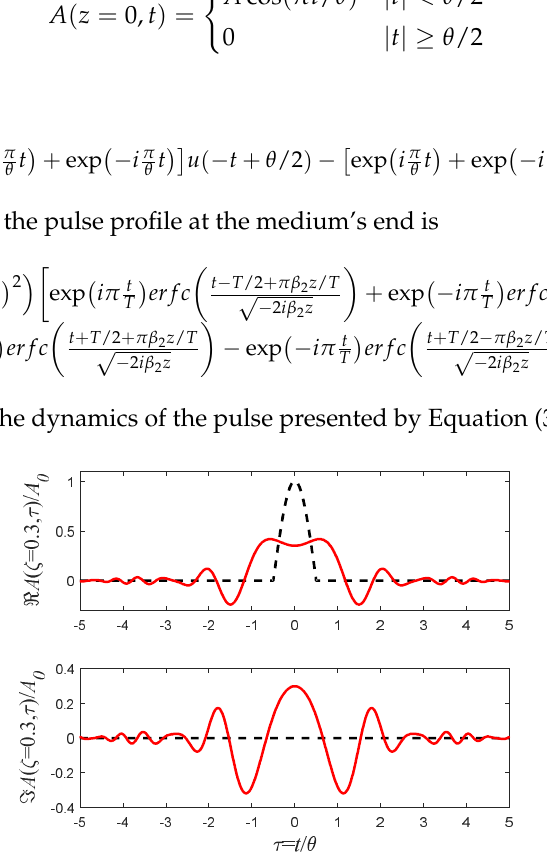
Figure 12. Similar to Figure 10, but for the bounded cosine pulse (Equation (39)) and for the final distance of ζ = β 2 z / θ 2 =